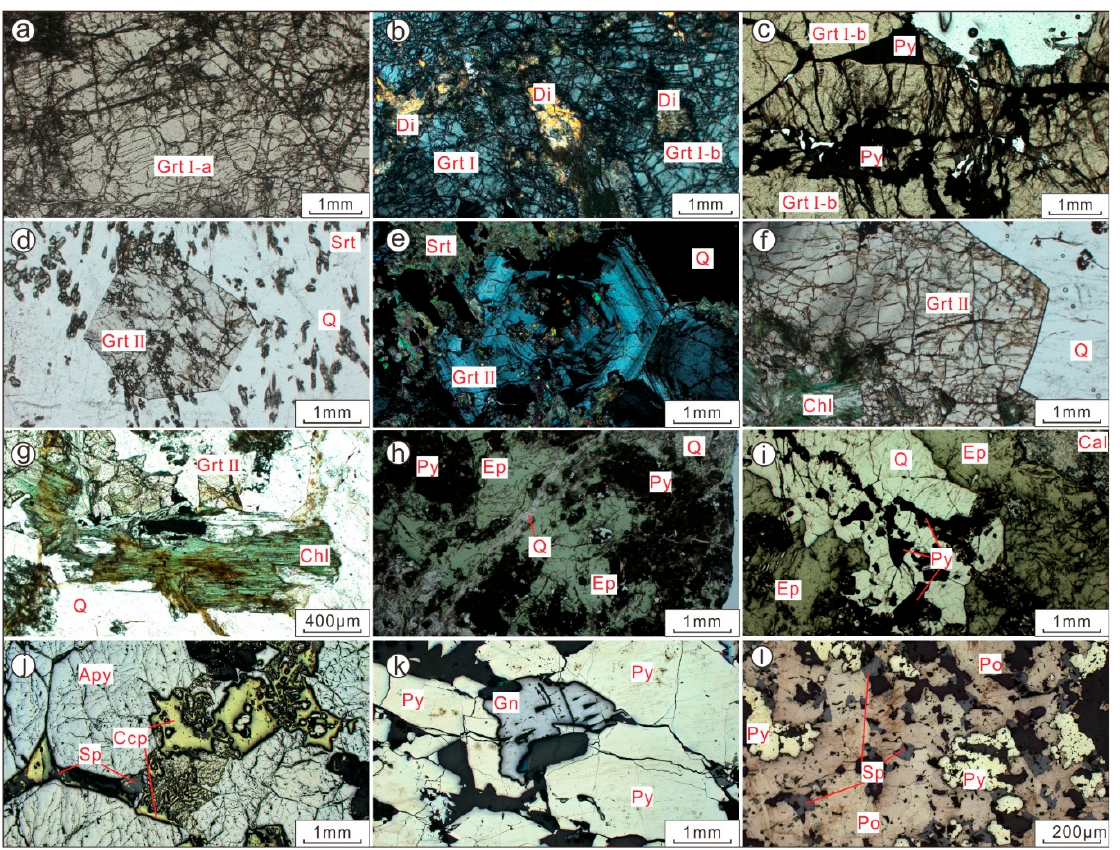
Figure 6. Micrographs show the petrographic characteristics and microstructure of skarn: ( a ) Graded skarn composed of Grt I, ( b ) primary skarn composed of Grt II with a small amount of diopside, ( c ) Grt II filled with a small amount of pyrite, no alteration, ( d ) Grt II associated with quartz, visible broken garnet particles; ( e ) Grt Is strongly altered by sericite, ( f ) garnet edge is replaced by chlorite, ( g ) the rim of Grt II is strongly replaced by chlorite, indicating pyrite mineralization, ( h )epidote forms a symbiotic relationship with pyrite, and quartz veins are cut-off, ( i ) epidote is cut by quartz, and pyrite minerals are found in quartz veins, ( j ) symbiotic chalcopyrite and sphalerite grow along the arsenopyrite fissure, ( k ) coexistence of pyrite and galena, ( l ) pyrite, pyrrhotite, and galena symbiosis. Abbreviate: Grt = garnet, Di = diopside, Srt = sericite, Ep = epidote, Chl = chlorite, Q = quartz, Py = pyrite, Ga = sphalerite, Sp = galena, Po = pyrrhotite, Ccp = chalcopyrite, Apy =